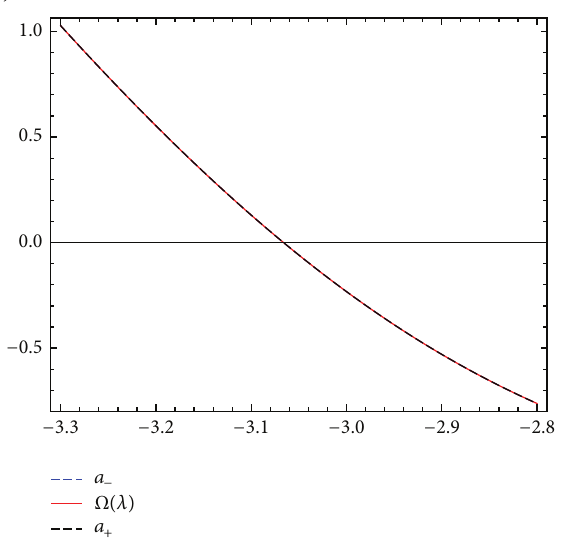
Figure 5: The enclosure interval dominating 𝜆 −2 for ℎ = 0.2 , 𝑁 = 25 , and 𝜀 = 10 −2 .